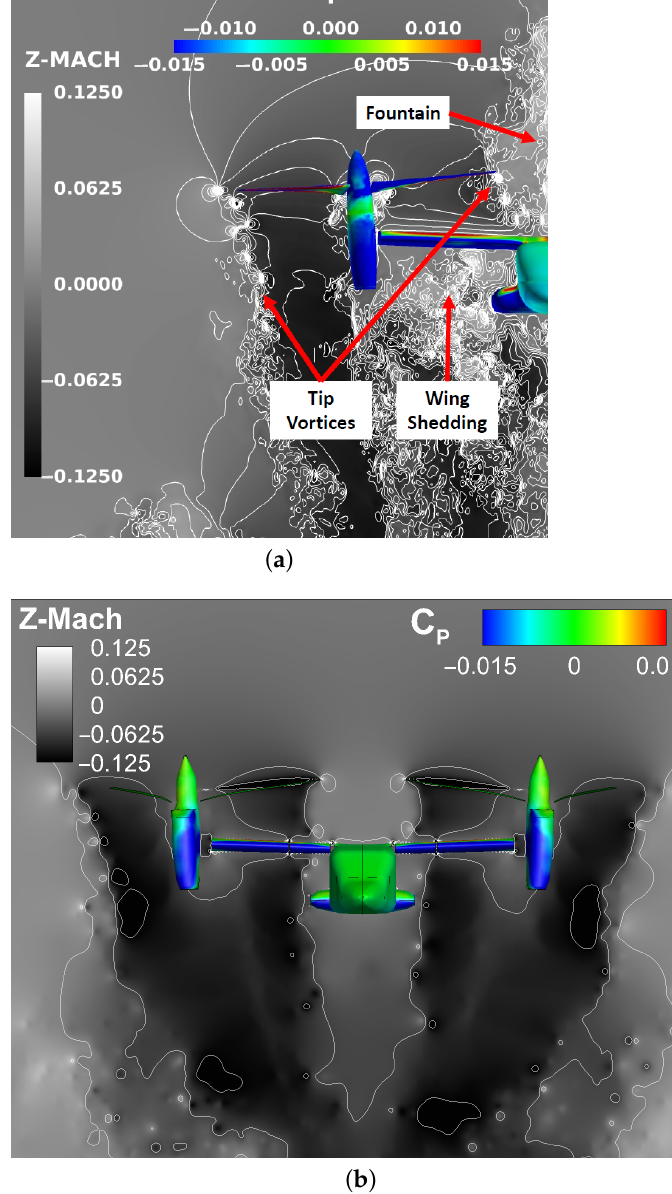
Figure 13. Comparison of the contours of the vertical velocity component around the vehicle in hover at ψ = 270 ◦ , θ N = 90 ◦ , Ω = 589 RPM. ( a ) Half-span model: CFD [17]; ( b ) Complete model: